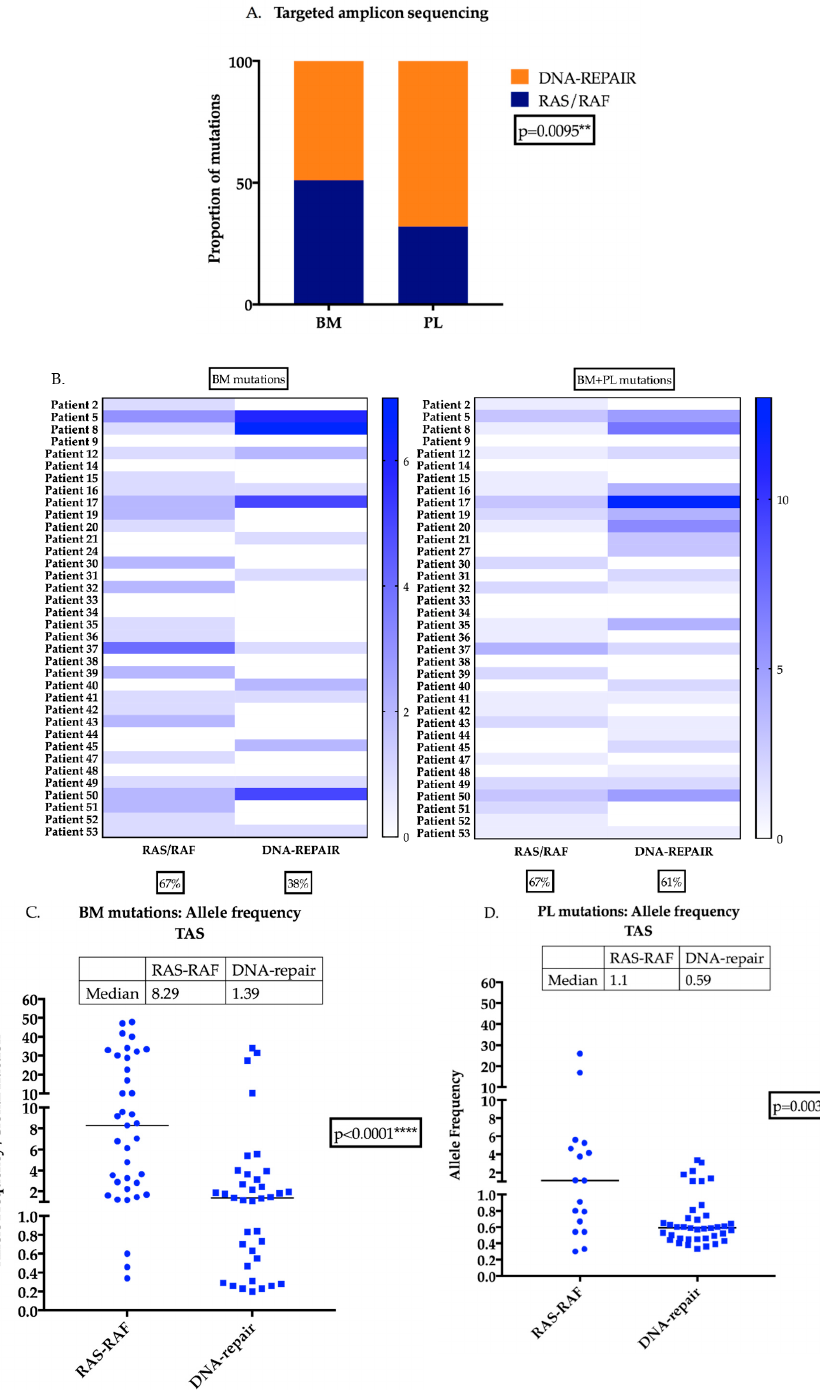
Figure 5. A higher prevalence of DNA-repair mutations in the PL of MM patients ( A ) TAS of DNA-repair genes ( ATM , ATR and TP53 ) and RAS-RAF ( KRAS , NRAS and BRAF ) was performed on 36 matched contemporaneously obtained BM and PL samples from ND and RR patients. In the BM, the prevalence of predicted deleterious variants were present in approximately equal proportions from both pathways. The proportion of variants present in DNA-repair genes was significantly higher when compared to RAS-RAF pathway variants in the PL (Chi-square test, ** p = 0.0095) ( B ) Proportion of patients with RAS-RAF variants were found to be equally present when information from BM and PL is considered with > 60% of patients harbouring variants. The number of patients with variants in DNA-repair pathway was higher when information from both BM and PL is considered. ( C ) AF of variants detected in the either RAS-RAF or DNA-repair pathway detected in the BM indicates that RAS-RAF pathway have a significantly higher median AF compared to DNA-repair ( D ) The PL AF of RAS-RAS and DNA-repair variants is significantly different although the difference is not as pronounced as in the case of the BM. (Pl: plasma, BM: bone marrow, AF: allele frequency) 3. Discussion Our study has revealed the utility of PL ctDNA analyses for comprehensive mutational characterisation and identification of mutations driving disease progression in MM patients. Data presented here has established that a higher number of detectable PL mutations is associated with significantly inferior OS, consistent with the hypothesis that increased spatial genetic heterogeneity represents an adverse biological state in MM, with a greater likelihood of resistance to therapy. Consequently, characterising such heterogeneity may be of particular importance in instances where a resistance mechanism is being sought to explain why some patients, particularly RR patients, are unresponsive to therapy. For example, differences in responsiveness to therapy may be able to be defined at the mutational level, whereby resistance to a specific drug is being conferred by the presence of one or more driver mutations in oncogenes and/or tumour suppressors with these lesions being more readily identifiable with liquid biopsy than single-site BM biopsy approaches. Adopting such a strategy to characterise the tumour-specific mutational landscape would provide a more informative avenue for personalised or biomarker-based therapy in MM, a disease where the genomic landscape of each individual tumour is heterogeneous and will change over time due to the selective pressures imposed on MM cells during therapy.